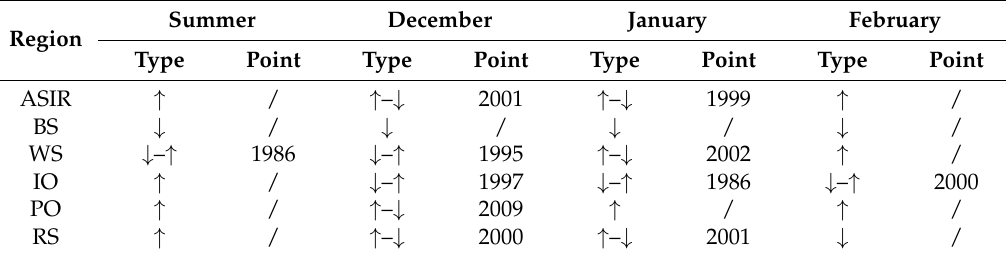
Figure 8. The same as Figure 7 but for SIC (% per year). Table 8. As in Table 5 but for SIC.